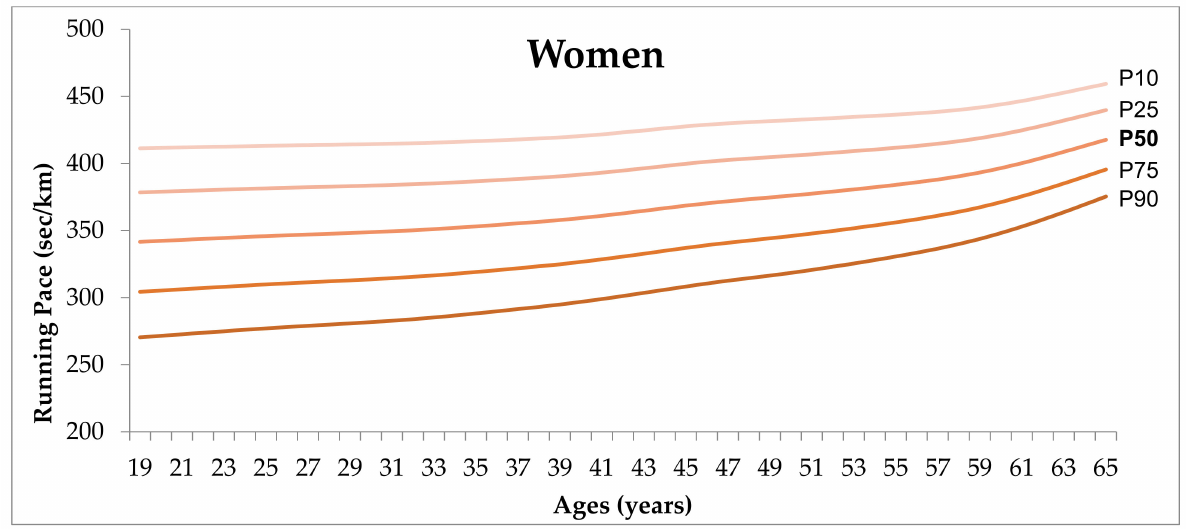
Figure 2. Percentile graph representing P10, P25, P50, P75, P90, of running pace for women, aged 19–65